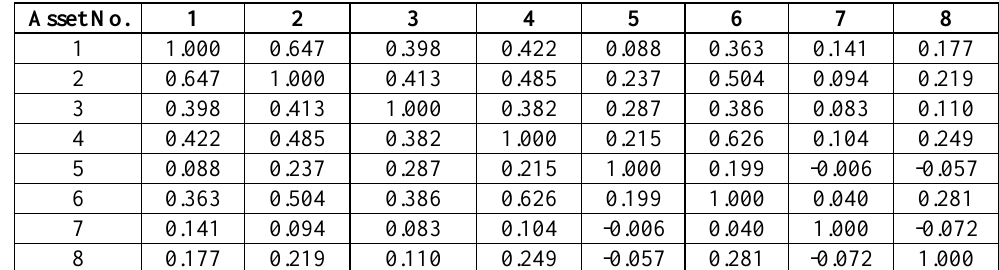
Table 3. The second scenario for the correlation coefficient matrix